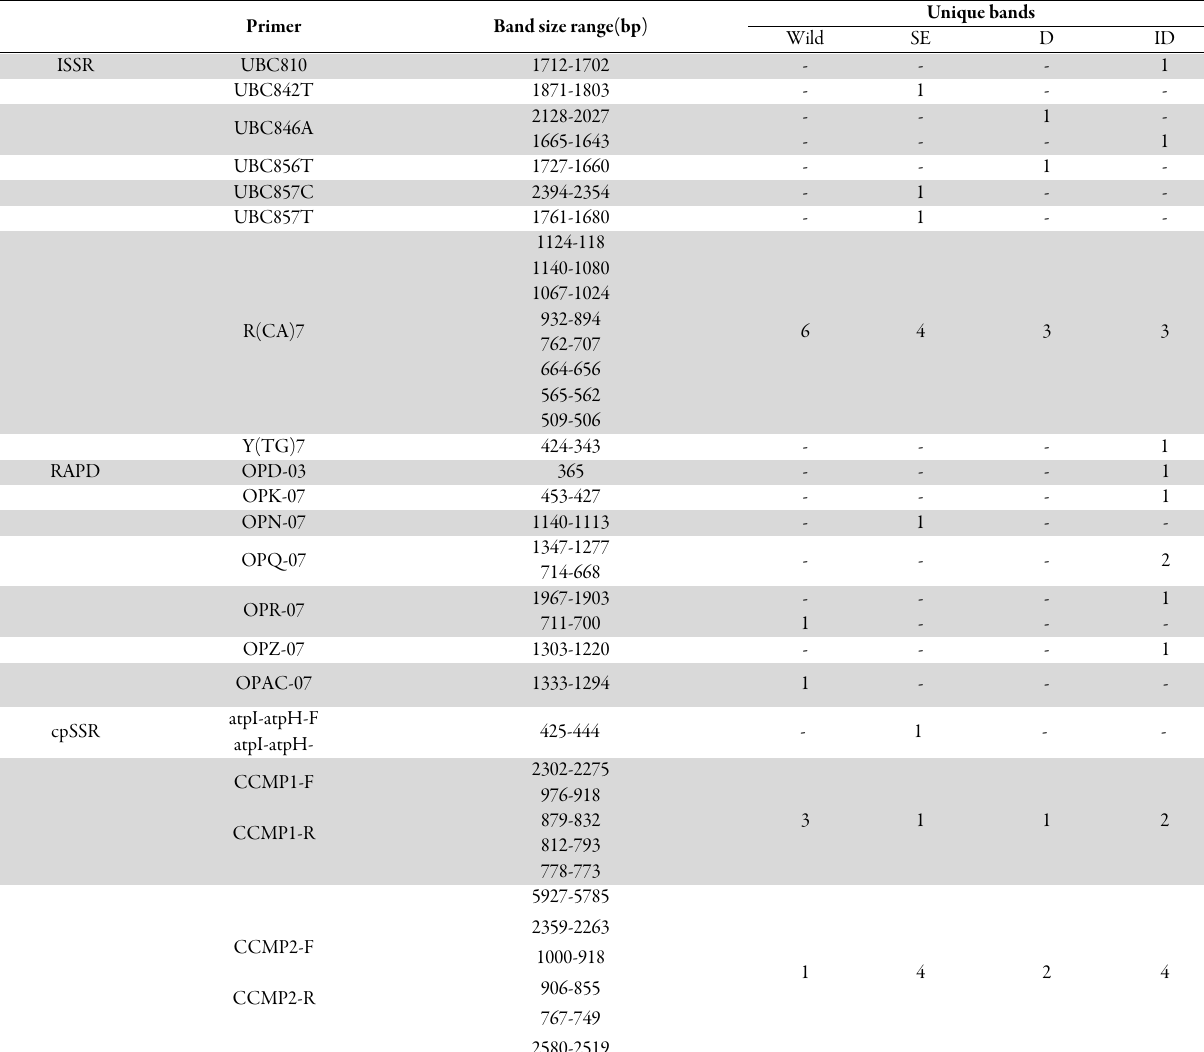
Table 4. Unique bands in wild plants and in vitro regenerated plant groups (W= wild, SE=somatic embryogenesis, D= direct, ID= indirect organogenesis)